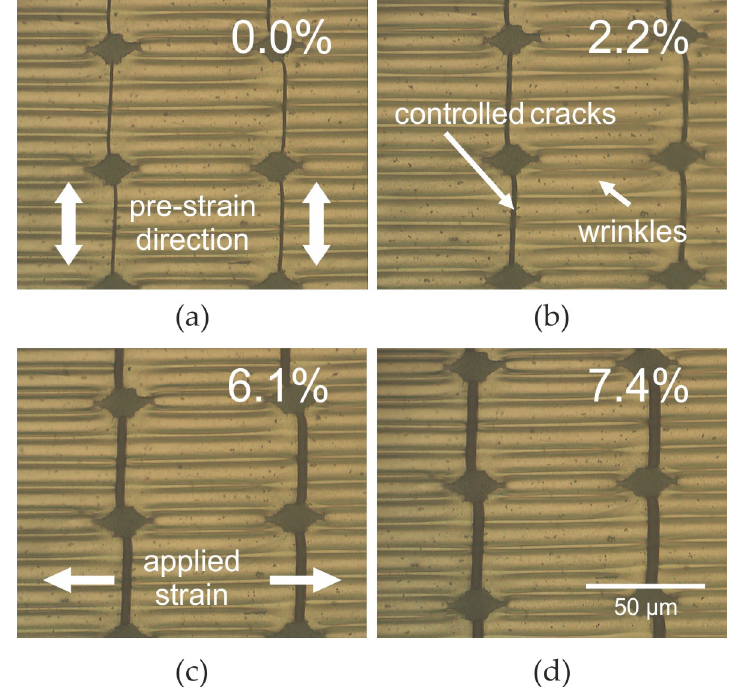
Figure 6. Optical micrographs of silver film containing controlled cracks and wrinkles under various strain of ( a ) 0%, ( b ) 2.2%, ( c ) 6.1%, and ( d ) 7.4%.